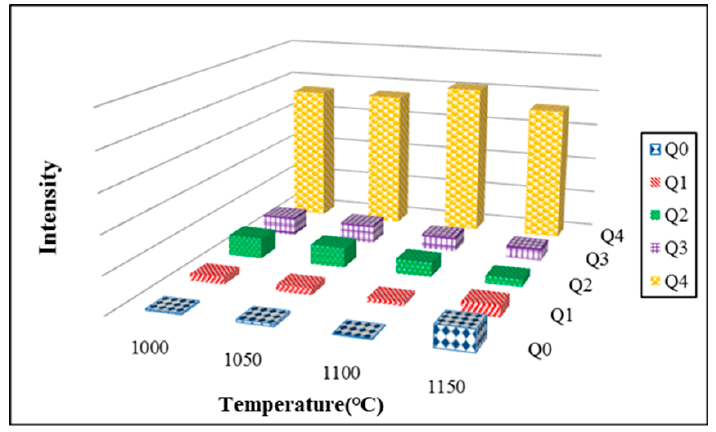
Figure 18. Si ‐ NMR results of 20% SSA and 20% MIBA at various kiln